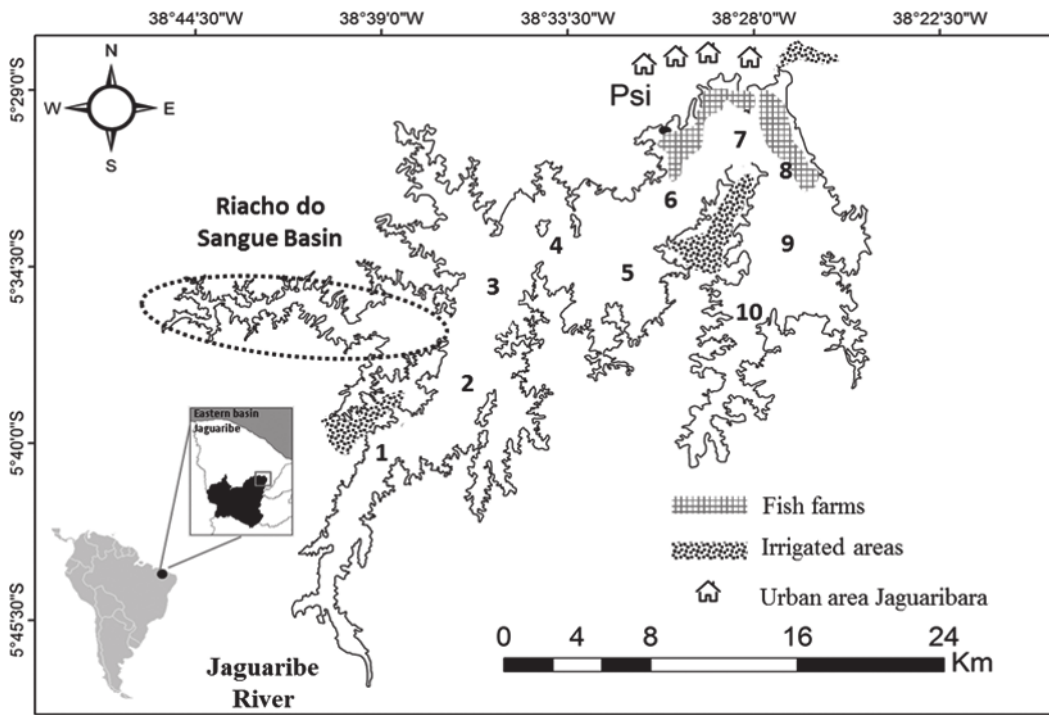
Figure 1 - The lake and basin of the Castanhão reservoir, Ceará State, NE Brazil, showing most signifi cant anthropogenic activities. Psi refers to the location sample station in the aquaculture farm mentioned in Figure 11. Numbers within the reservoir refer to sampling stations listed in Figures 8 and 9. Adapted from Santos et al.